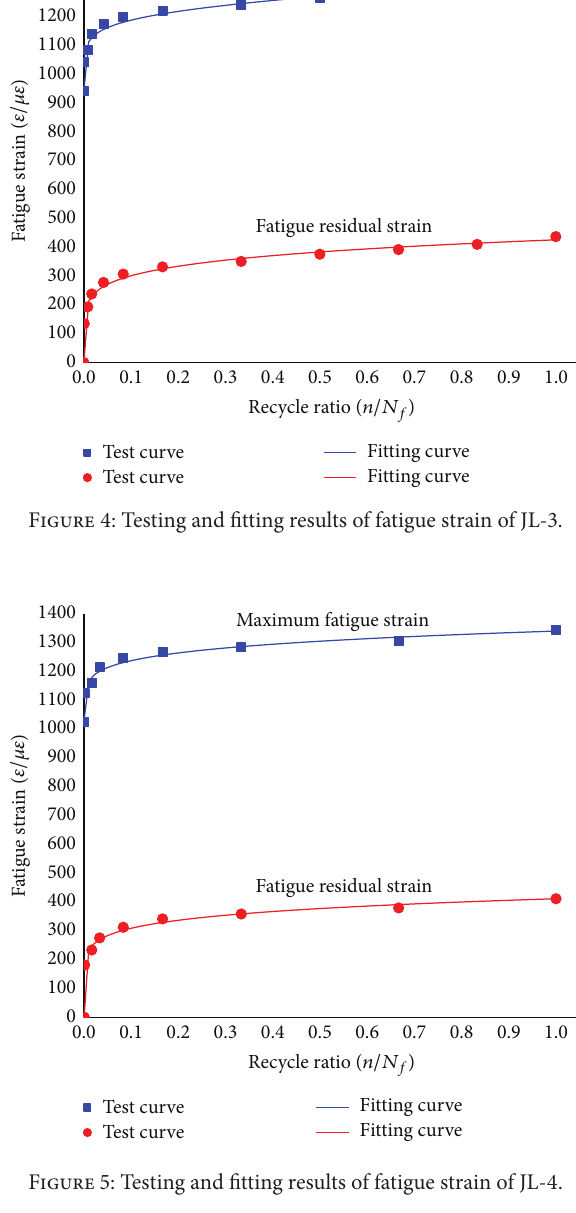
Table 4: Coefficients of evolution equation.